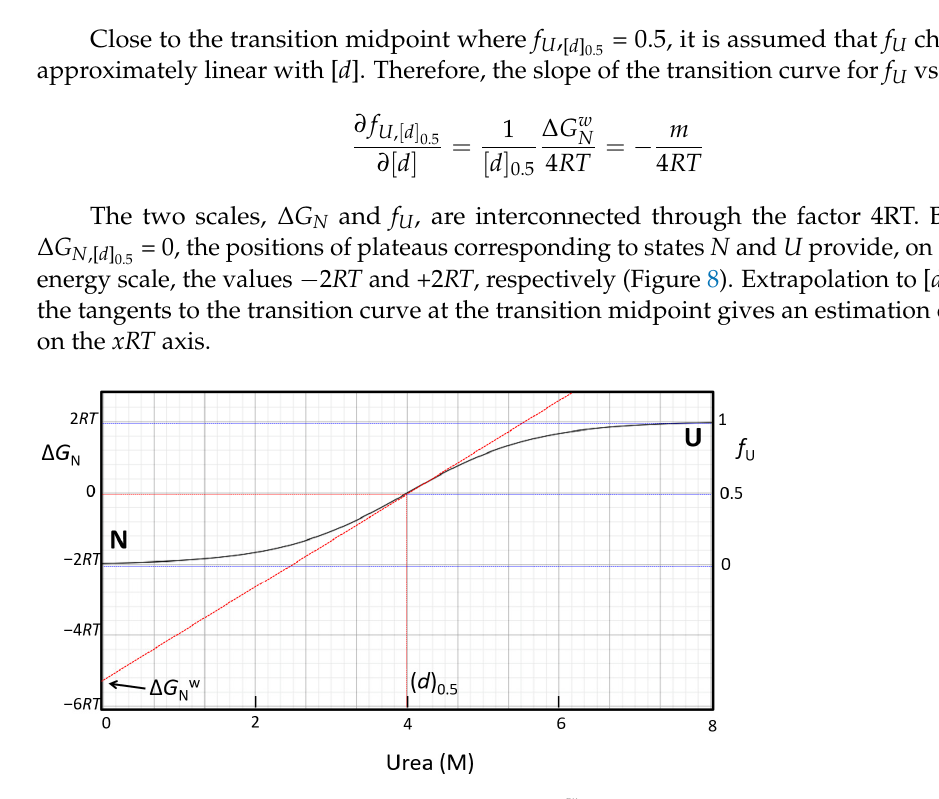
N , by linear extrapolation to zero concentration